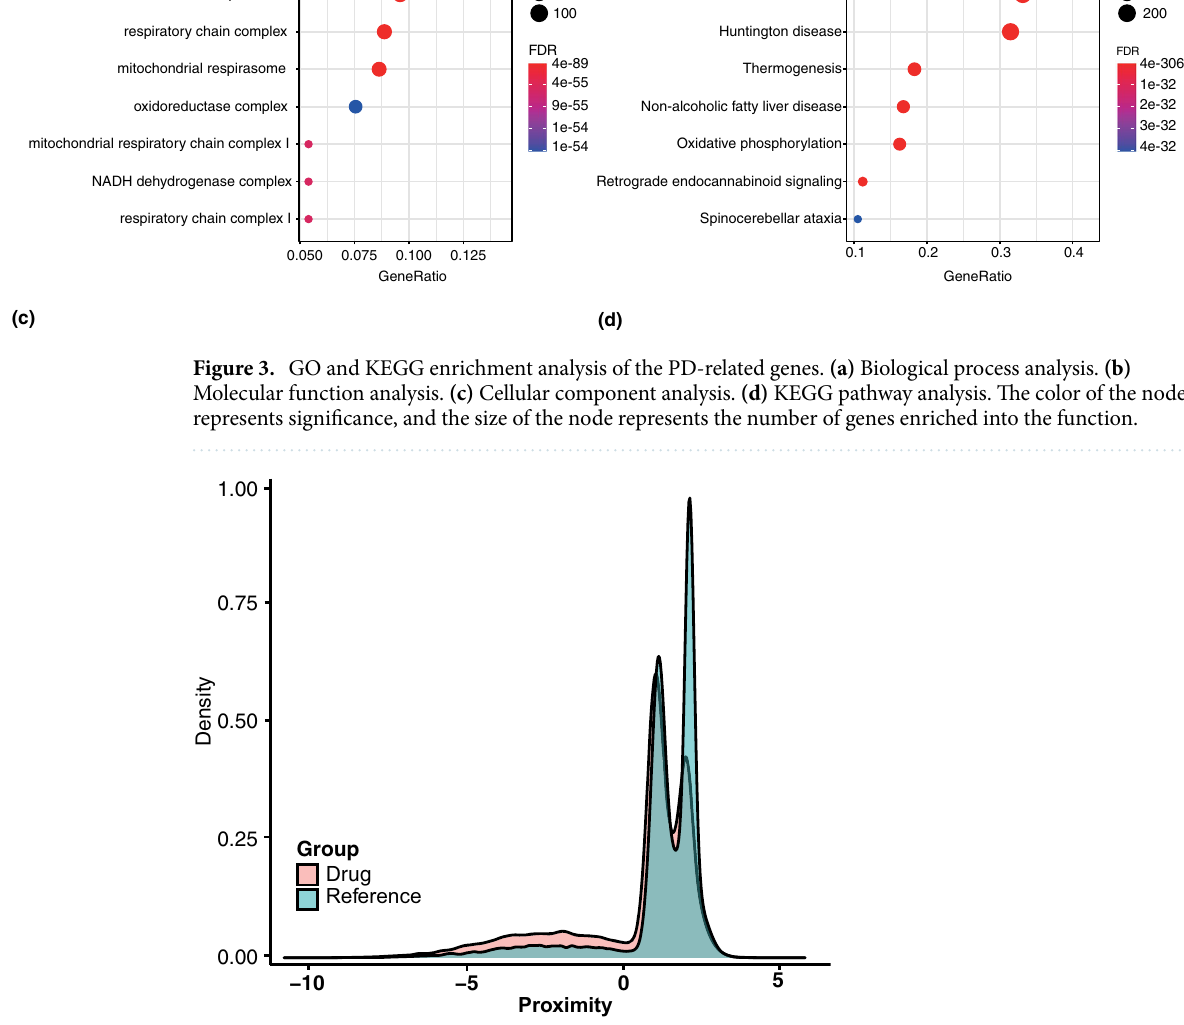
Figure 4. Proximity between drugs and PD. Density plot showing the distance distribution of all drugs to PD-related genes (pink) and the reference data